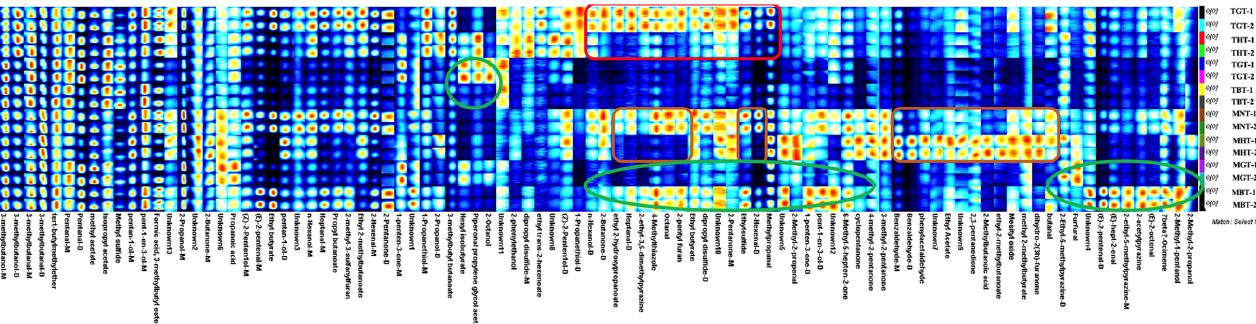
Figure 3. Fingerprints of eight types of lotus-leaf-tea samples. Each column represents a compound. Two parallels in each group. (“M”, monomer and “D”, dimer) detected via HS-GC-IMS. By contrast, in the mature groups, the naturally dried lotus-leaf tea possessed three types of aldehydes, which were heptanal, octanal and 2-hexenal and three types of heterocyclic compounds, which were 4-methylthiazole, 2-pentyl furan and 2-ethyl-3,5- dimethylpyrazine. Compared with naturally dried lotus-leaf tea, several esters, aldehydes, ketones, and one type of heterocyclic compound and acid were identified in hot-air dried lotus leaf samples. These were: dihydro-2(3h)-furanone, methyl 2-methylbutyrate, ethyl- 2-methylbutanoate, ethyl butyrate, butanal, benzaldehyde, phenylacetaldehyde, mesityl oxide, 2,3-pentanedione, 2-ethyl-5-methylpyrazine and 2-methylbutanoic acid. However, Shi et al. reported that the content of benzaldehyde among green, black and white tea from purple-colored leaves was black tea > white tea > green tea [36]. The result was